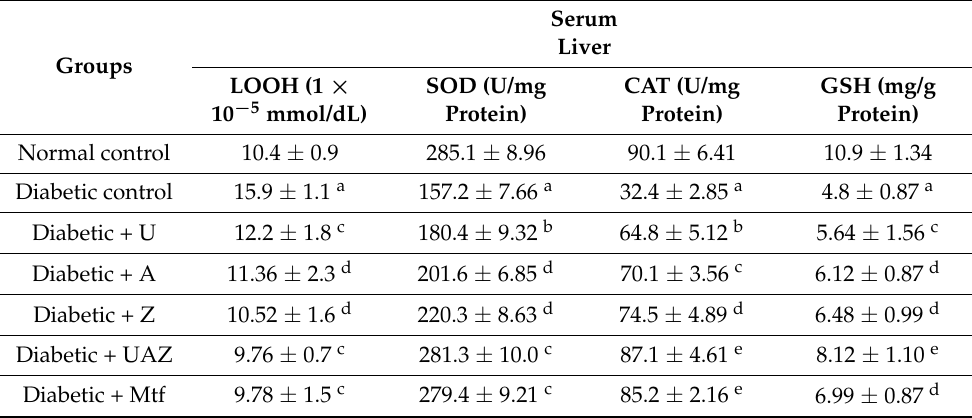
Table 5. Effect of U, A, and Z and UAZ on lipid hydroperoxides (LOOH) in serum and hepatic contents in antioxidant enzymes SOD, CAT, and antioxidant molecules GSH in ZTZ-induce